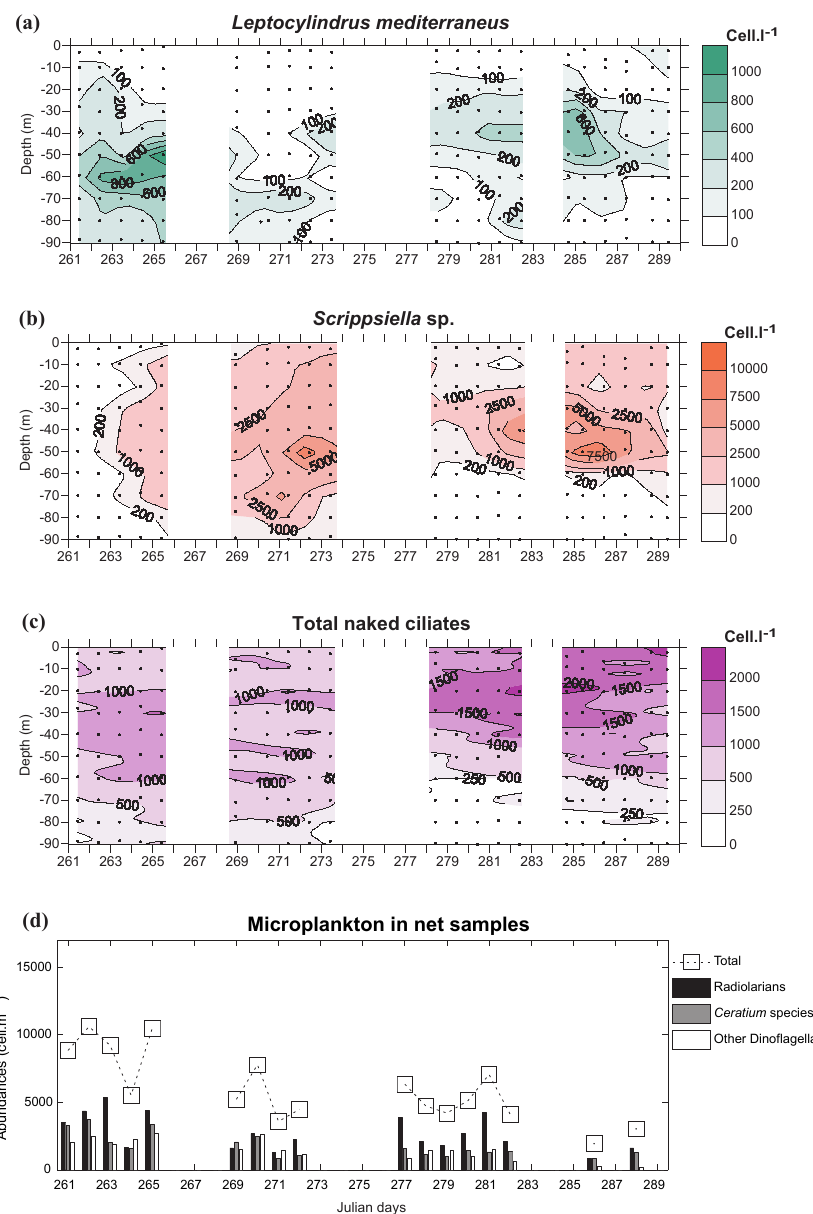
Fig. 3. Abundance of ecologically important planktonic organisms during DYNAPROC 2 cruise, from hydrological bottle sampling (a) The diatom Leptocylindrus mediterraneus , (b) The dinoflagellate Scrippsiella sp., (c) Naked ciliates, and from net sampling (d) Dinoflagellates genera and Ceratium infraspecific